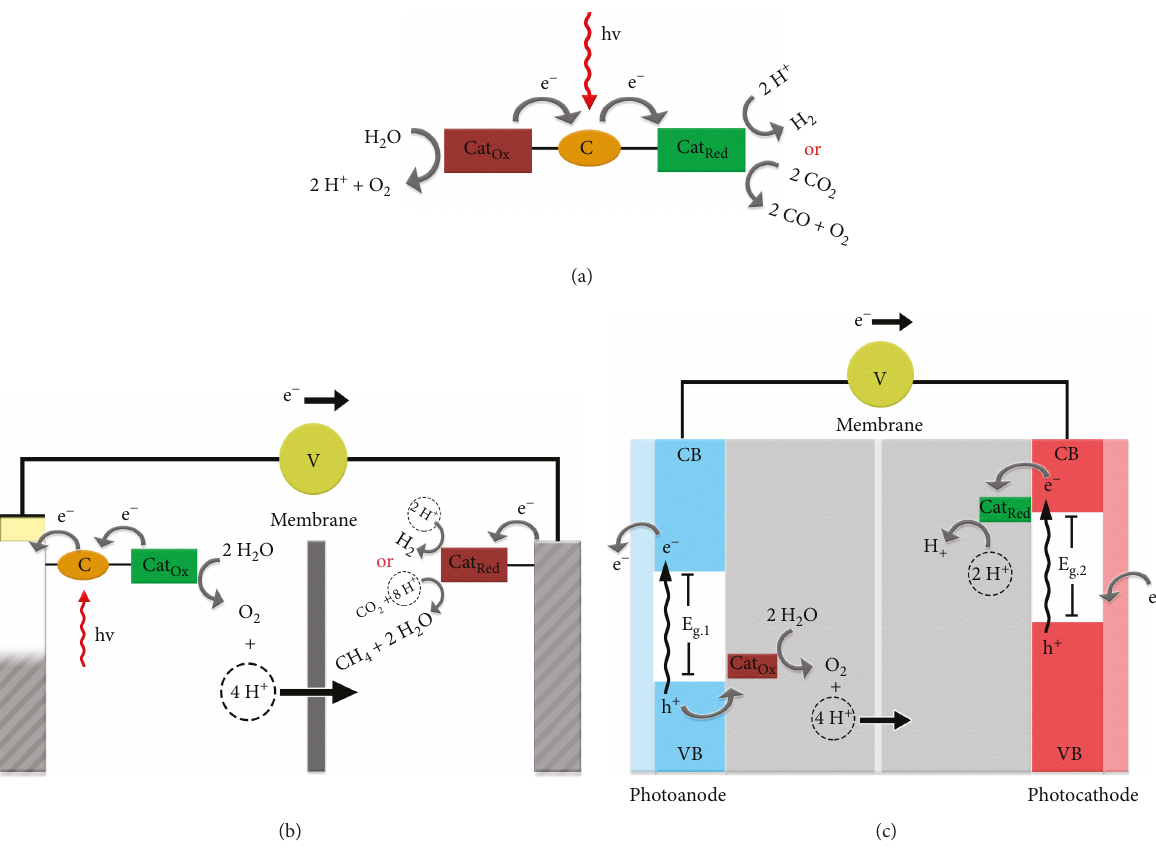
Figure 1: Basic components of an arti fi cial photosynthetic system assembled in di ff erent ways. (a) Three-component arti fi cial photosynthetic system physically connected. (b) Photoanode-driven photoelectrochemical cell. (c) Tandem photoelectrochemical cell comprised by a photoanode and a